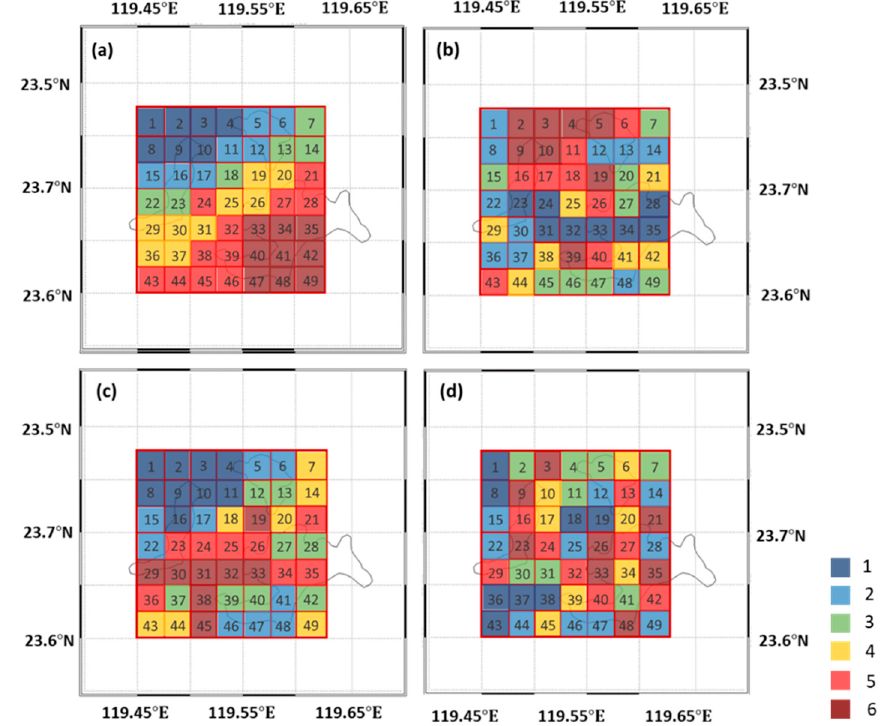
Figure 7. Spatial distributions of the average variable influence scores of ( a ) SST anomalies (SSTAs), ( b ) chlorophyll-a (chl-a) concentration ( c ) cold-water (<15 °C) intrusion days ( InD s), and ( d ) offshore distance from the PHI coastline map for all 49 gridded areas in the inner bay of the PHI during extreme events (category C).